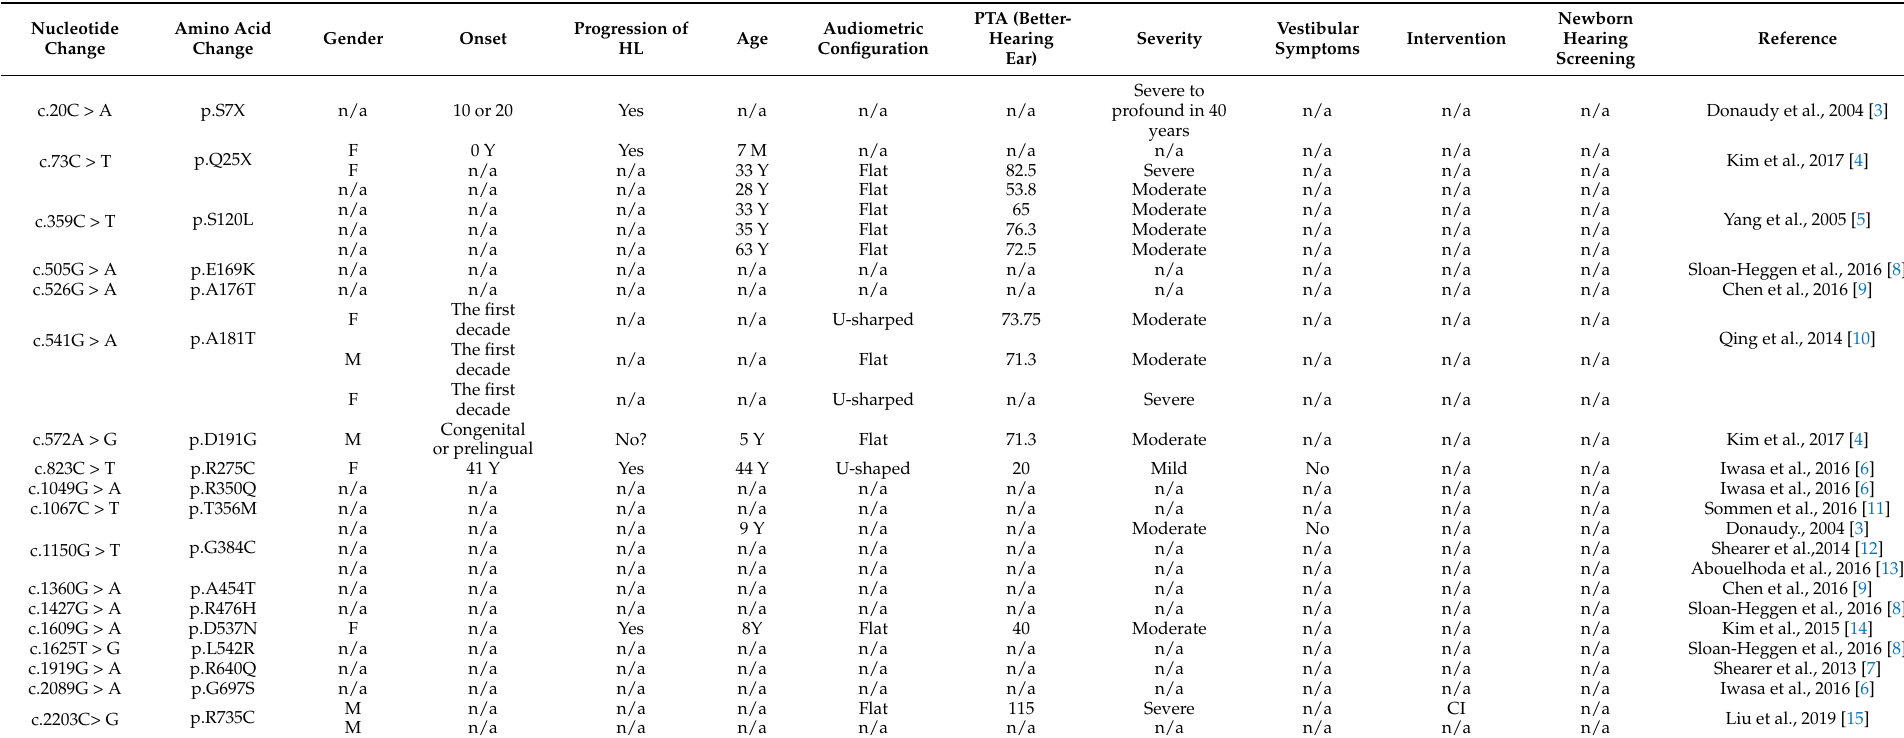
Table 3. MYH14 variants and clinical information in previous reports (all MYH14 variants are indicated in